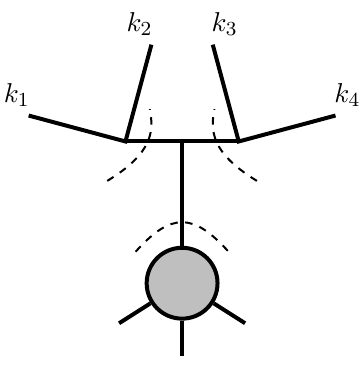
Figure 8 . The cutted propagators of this Feynman diagram are on-shell, this together with mo- mentum conservation at the cubic vertices forces k 1 and k 3 to be